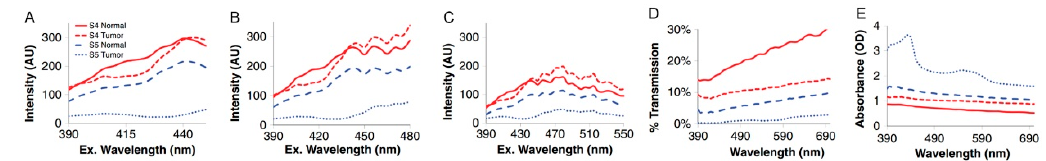
Figure 8. Spectral differences between normal and cancerous tissue for two specimen pairs: S4 and S5 presented in [83]. Preliminary data demonstrate the differences in spectral signature between cancerous and normal tissue. Transmission and absorbance spectral data indicate that adenocarcinoma displays increased optical absorbance, as compared to surrounding normal tissue, with additional spectral differences that could be exploited to increase sensitivity and specificity for tumor detection. Spectral scan types are as follows: ( A ) Fluorescence excitation scan from 390 to 450 nm; ( B ) Fluorescence excitation scan from 390 to 480 nm; ( C ) Fluorescence excitation scan from 390 to 550 nm; ( D ) Transmission scan from 390 to 700 nm; ( E ) Absorbance scan from 390 to 700 nm.